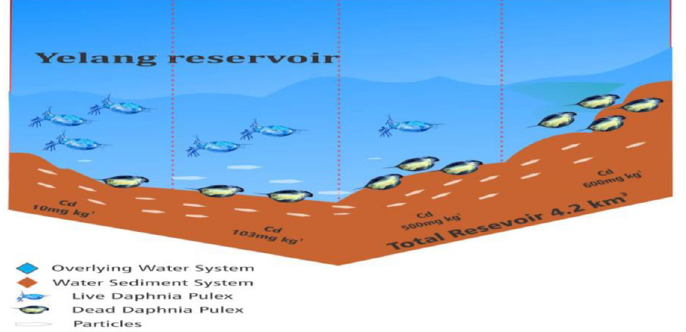
Figure 5. Highlighting the mortality rate of Daphnia pulex under different Cd pollution levels in sediments.